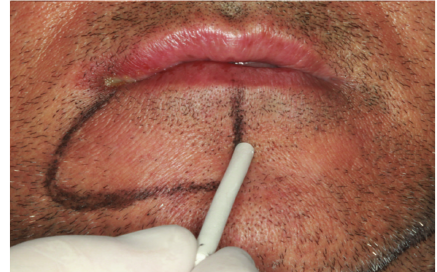
Figure 33: Tactile discrimination test.